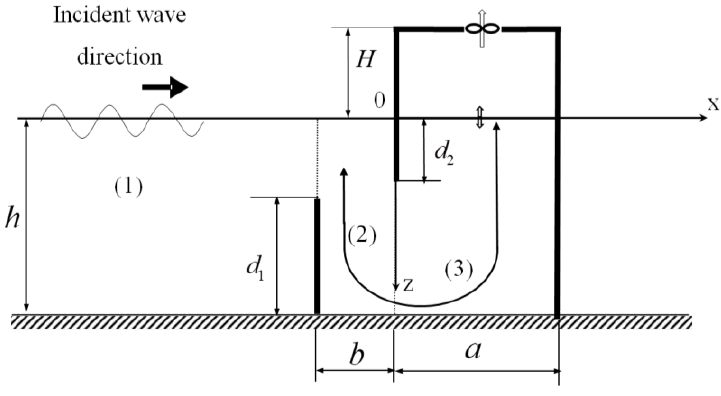
Figure 1. Schematic sketch of a U-OWC